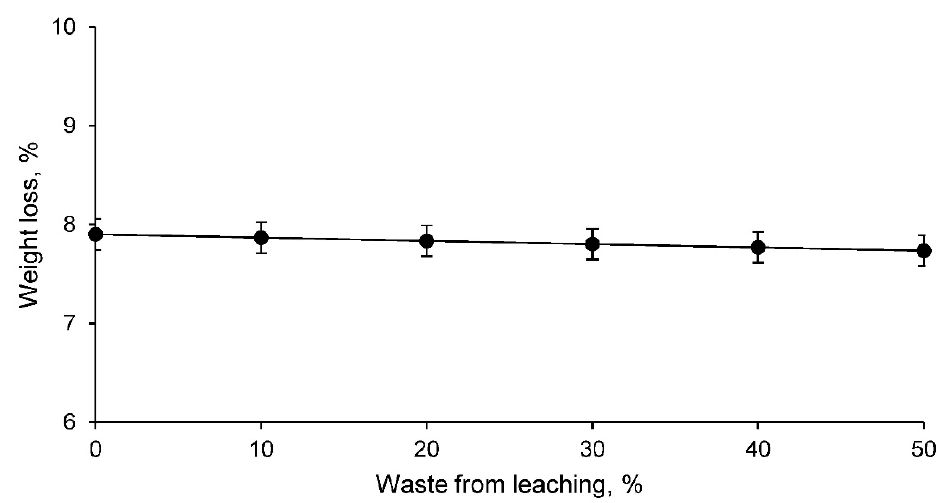
Figure 5. Weight loss of different families of conformed ceramics with clay and leaching residue.